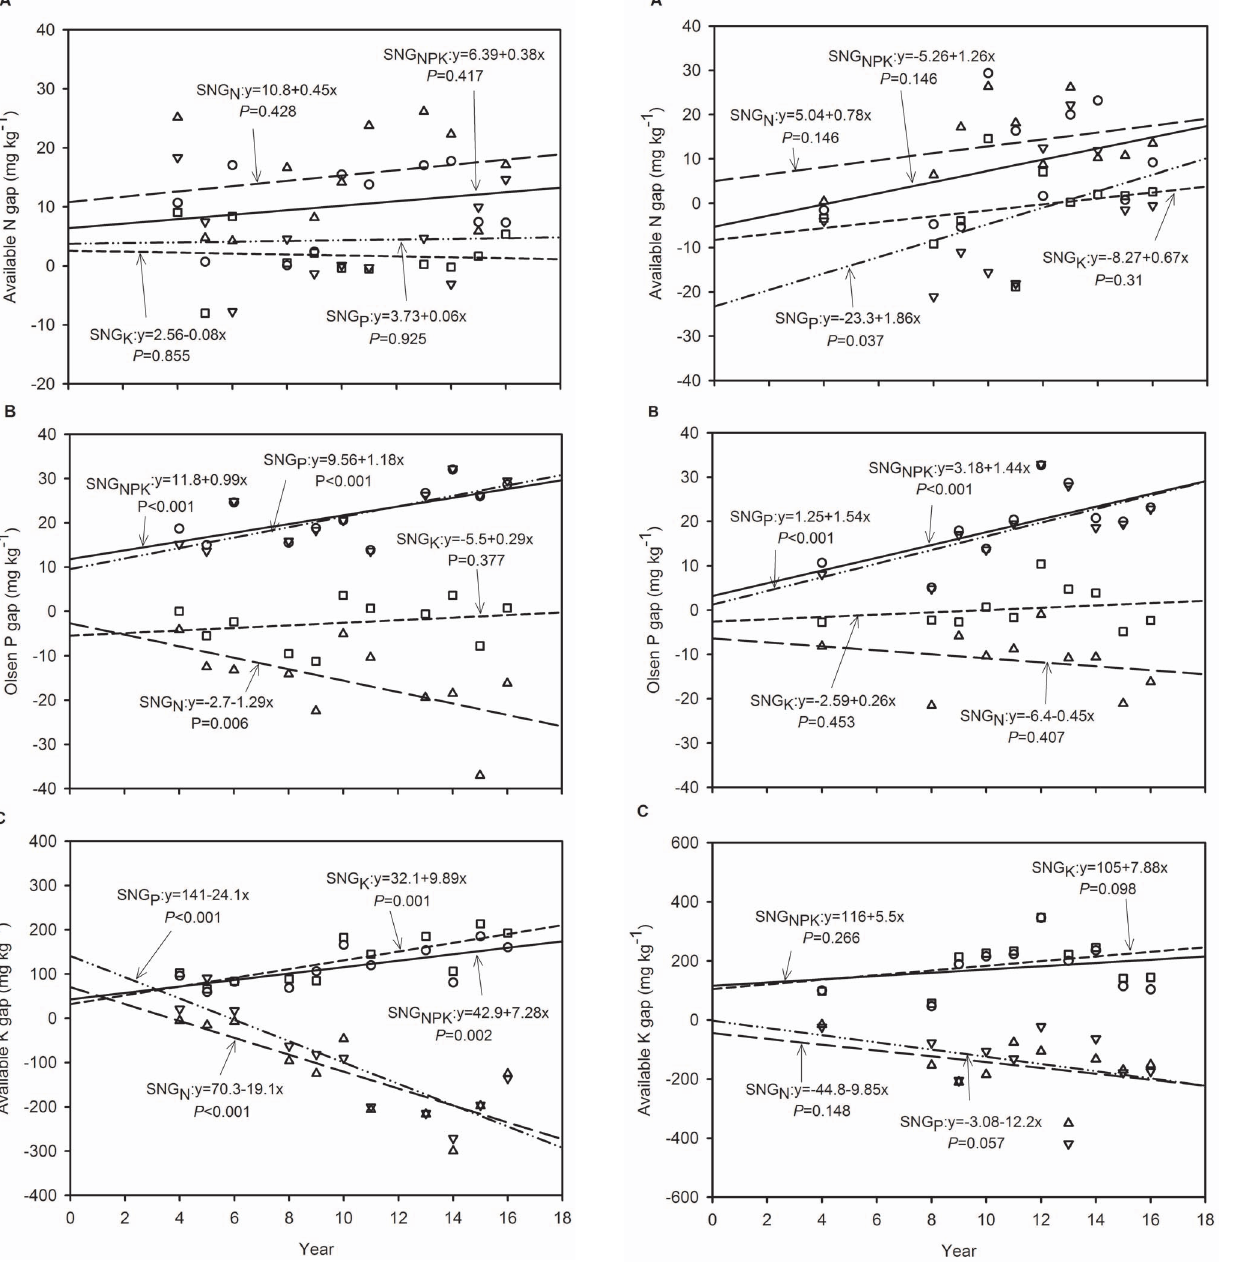
Figure 4. Soil available N (a), Olsen-P (b) and available K (c) gap variation by N (SNG N , soil available nutrient difference between NPK and PK plots, triangle up), P (SNG P , the difference between NPK and NK plots, triangle down), K (SNG K , the difference between NPK and NP plots, square) or NPK (SNG NPK , the difference between NPK and Control plots, circle) fertilizer omission from 1994 to 2006 during maize season at Yucheng, Shandong Province of China.